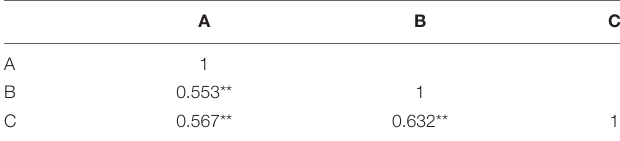
FIGURE 4 | Validity analysis results of work engagement questionnaire ( χ 2 : approximate chi square; Df: degree of freedom; Sig: Significance level).